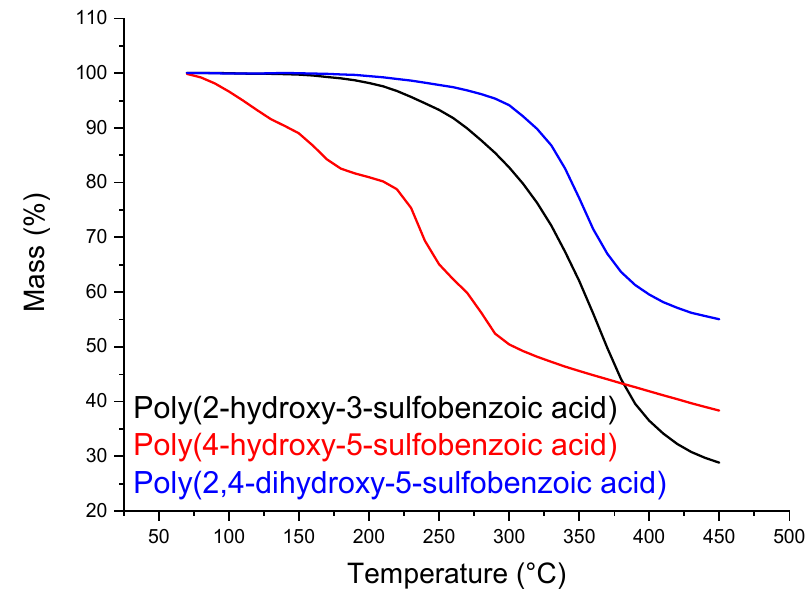
Figure 13. Thermogravimetric analysis of the sulfonated oligomers (Oligocat). In Figure 13, poly(2-hydroxy-5-sulfobenzoic acid) initiates the mass loss at 220 ◦ C until 270 ◦ C, which can be assigned to the separation of the sulfonic groups from the polymeric chain and, at 360 ◦ C, the polymeric chain cleavage occurs [42]. TGA curve of poly(4-hydroxy-5-sulfobenzoic acid) presented less thermal stability. From 120 to 160 ◦ C occurs the sulfonic groups degradation and, at 240 ◦ C, the cleavage of the polymeric chains most probably occurs. Poly(2,4-dihydroxy-5-sulfobenzoic acid) presented a similar thermal profile as poly(2-hydroxy-5-sulfobenzoic acid). Nevertheless, a considerable mass is remained, which can indicate better stability.